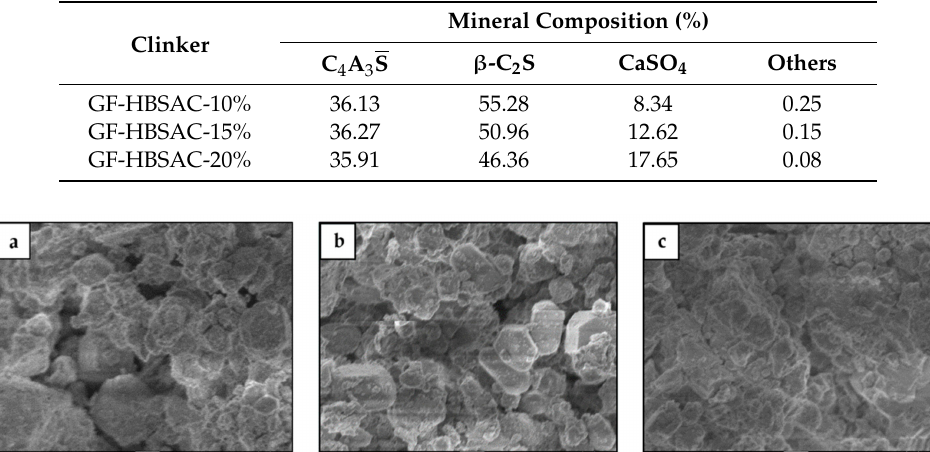
Table 6. Mineral composition of the Series GF-HBSAC-Y cement clinkers.